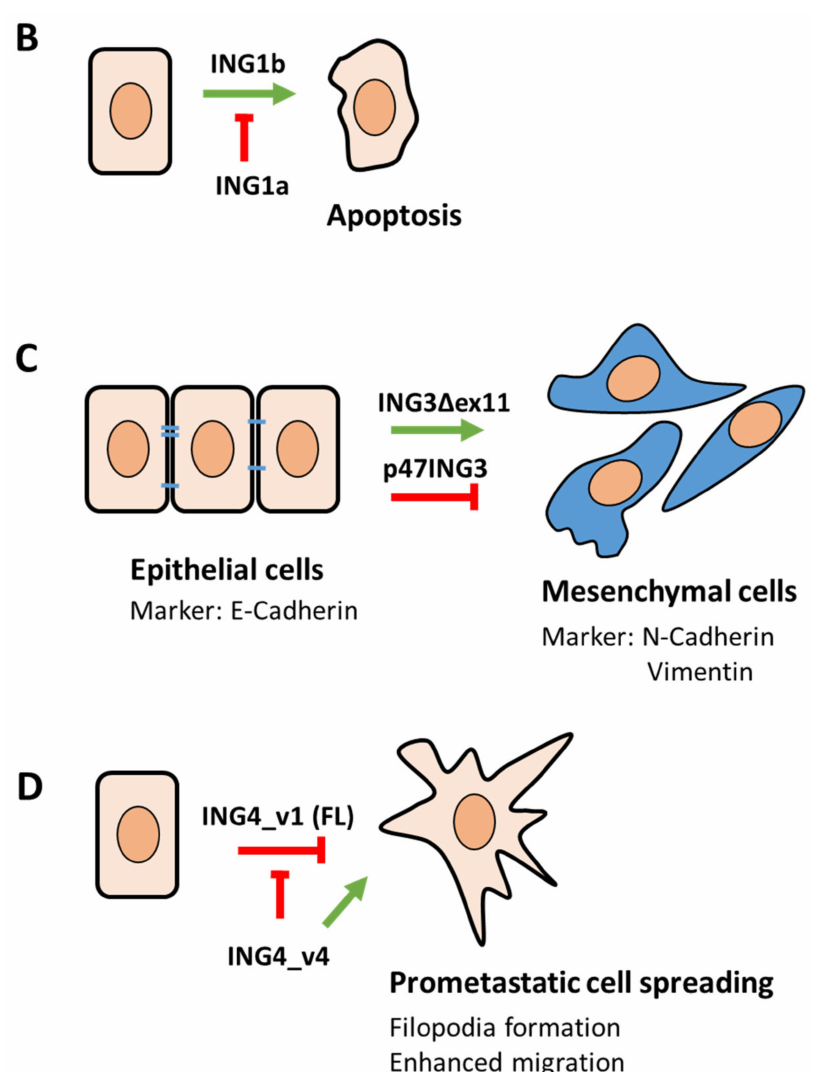
Figure 2. The balance of different ING splice variants expression determines the effect on tumour cells. ( A ) When the expression proportion of ING tumour suppressor isoform increases, ING-mediated tumour suppression is activated in tumour cells. It negatively regulates cell proliferation, migration, and invasion. If ING splice variants equilibrium is shifted to the side of oncogenic/counteractive ING isoforms, tumour suppressive effect is abolished. ING splice variants can functionally counteract in tumour cells. ( B ) ING1a inhibits ING1b-induced apoptosis. ( C ) p47ING3 (full-length) acts as a tumour suppressor and inhibits EMT keeping PC cells in an epithelial state. ING3 ∆ ex11 that lacks PHD motif induces EMT in PC cells. ( D ) ING4_v1 (full-length) inhibits premetastatic cell spreading, filopodia formation in malignant cells. ING4_v4 lacking NLS totally abolishes ING4_v1 (full-length)-mediated inhibition of filopodia